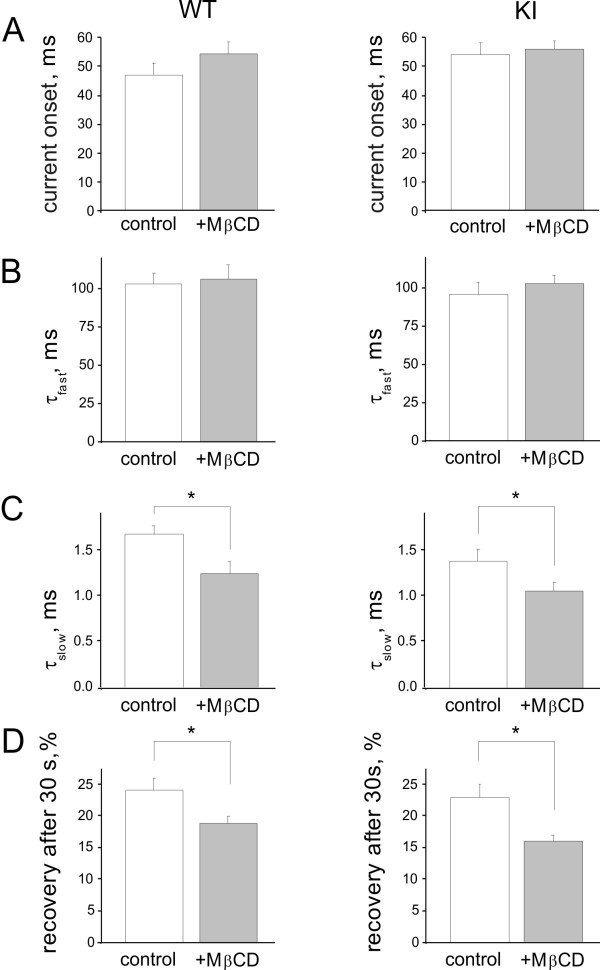
Properties of P2X3 receptor mediated responses of WT and KI neurons. Histograms quantify the different properties of P2X3 receptors in WT (left) or KI (right) trigeminal neurons in control and after MβCD treatments. Note that MβCD treatment accelerates the slow desensitization time constant and slows down the degree of recovery from desensitization in WT and KI neurons (tested at 30 s interval). Data refer to effects induced by 10 μM α,β-meATP. A, current onset expressed as 10-90% response rise time. Control: n = 20 for WT and n = 25 for KI. MβCD: n = 15, p > 0.05 for WT; n = 27, p > 0.05 for KI. B, desensitization onset (fast desensitization time constant, τfast) Control: n = 18 for WT and n = 20 for KI. MβCD: n = 12, p > 0.05 for WT and n = 24, p > 0.05 for KI. C, retarded current decay (slow desensitization time constant, τslow). Control: n = 18 for WT and n = 20 for KI. MβCD: n = 11, p < 0.01 for WT and n = 21, p = 0.04 for KI. D, recovery from desensitization, expressed as % of control response amplitude with 30 s paired pulse protocol of α,β-meATP application. Control: n = 12 for WT and n = 16 for KI. MβCD: n = 7, p = 0.03 for WT and n = 11, p < 0.01 for KI.